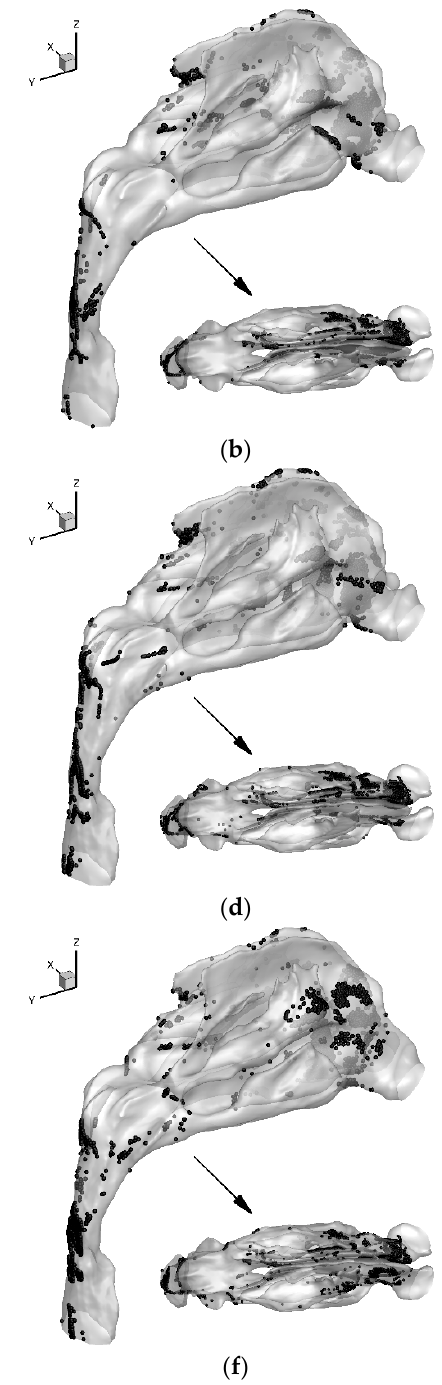
model, ( d ) Right and top views of the deposition pattern for VS1 model, ( e ) Left view of the deposition pattern and locations of escaped particles at the outlet for VS2 model, ( f ) Right and top